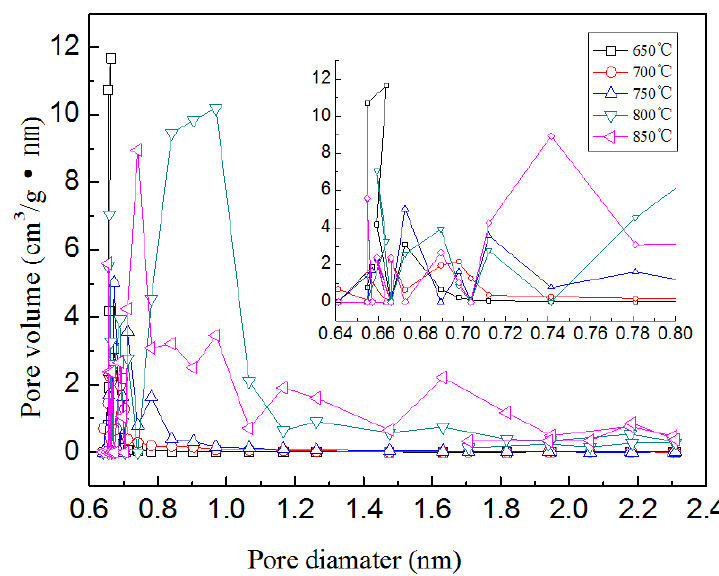
Figure 6. The pore size distributions for BACFs (HK method).